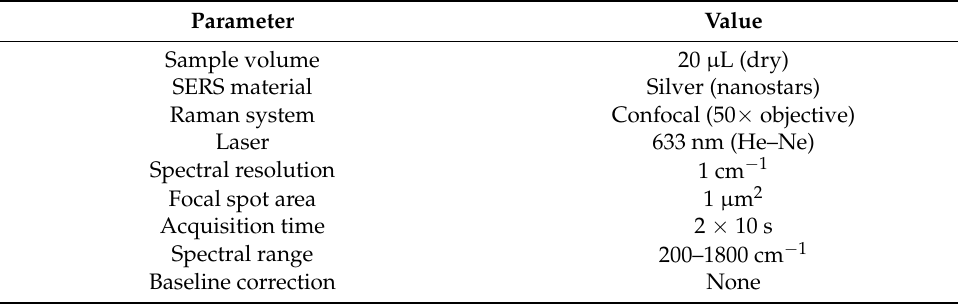
Table 1. Parameters and respective values for the optimized SERS–AgNS protocol.